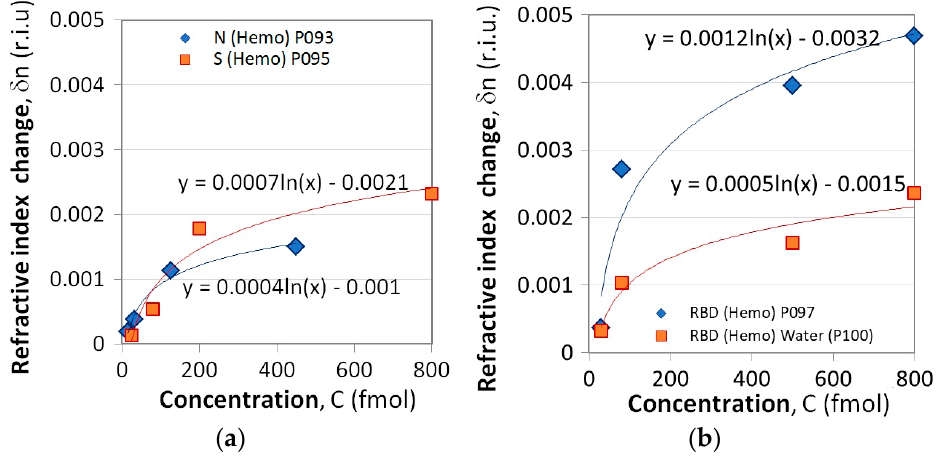
Figure 6. Refractive index change as a result of Hb binding to: ( a ) N and S proteins, ( b ) RBD proteins. Using the Excel built-in fi tt ing function, the δ n ( C ) dependencies were fi tt ed with a logarithmic function as